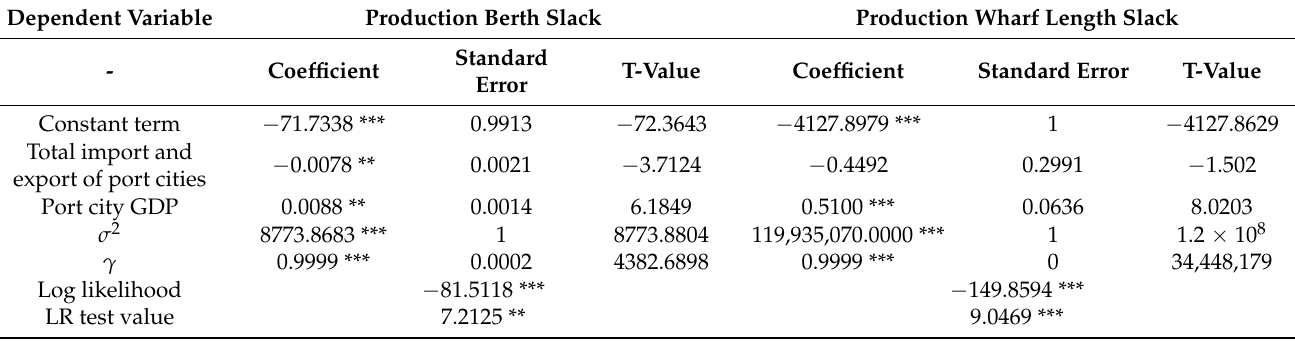
Table 5. The second stage SFA regression